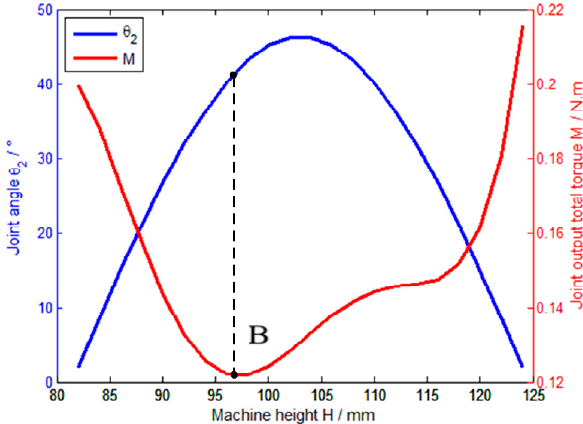
Figure 8. Minimum M under di ff erent center of gravity heights .